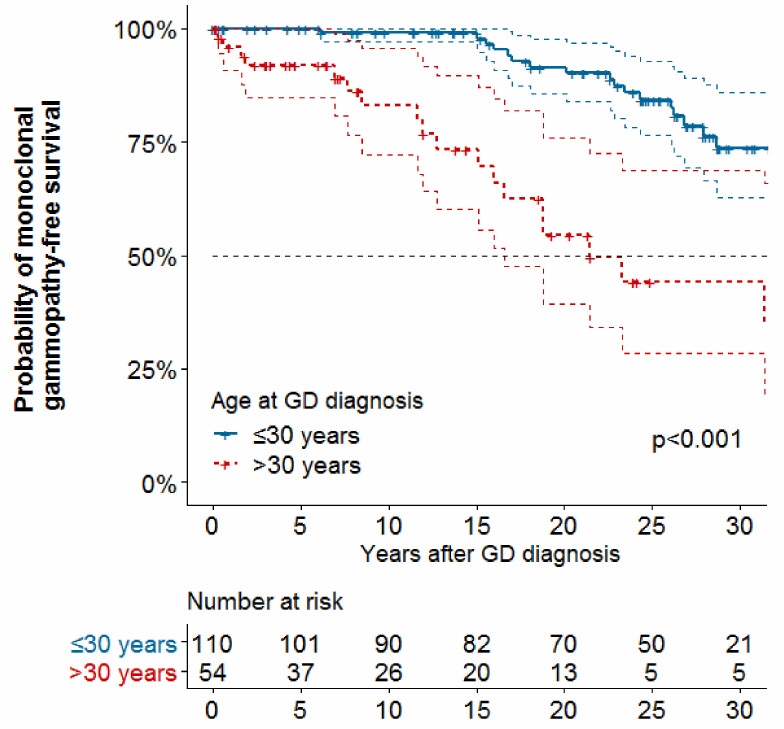
Figure 1. Kaplan-Meier curve of survival without monoclonal gammopathy by age at Gaucher disease diagnosis ( n = 164). No: number; GD: Gaucher